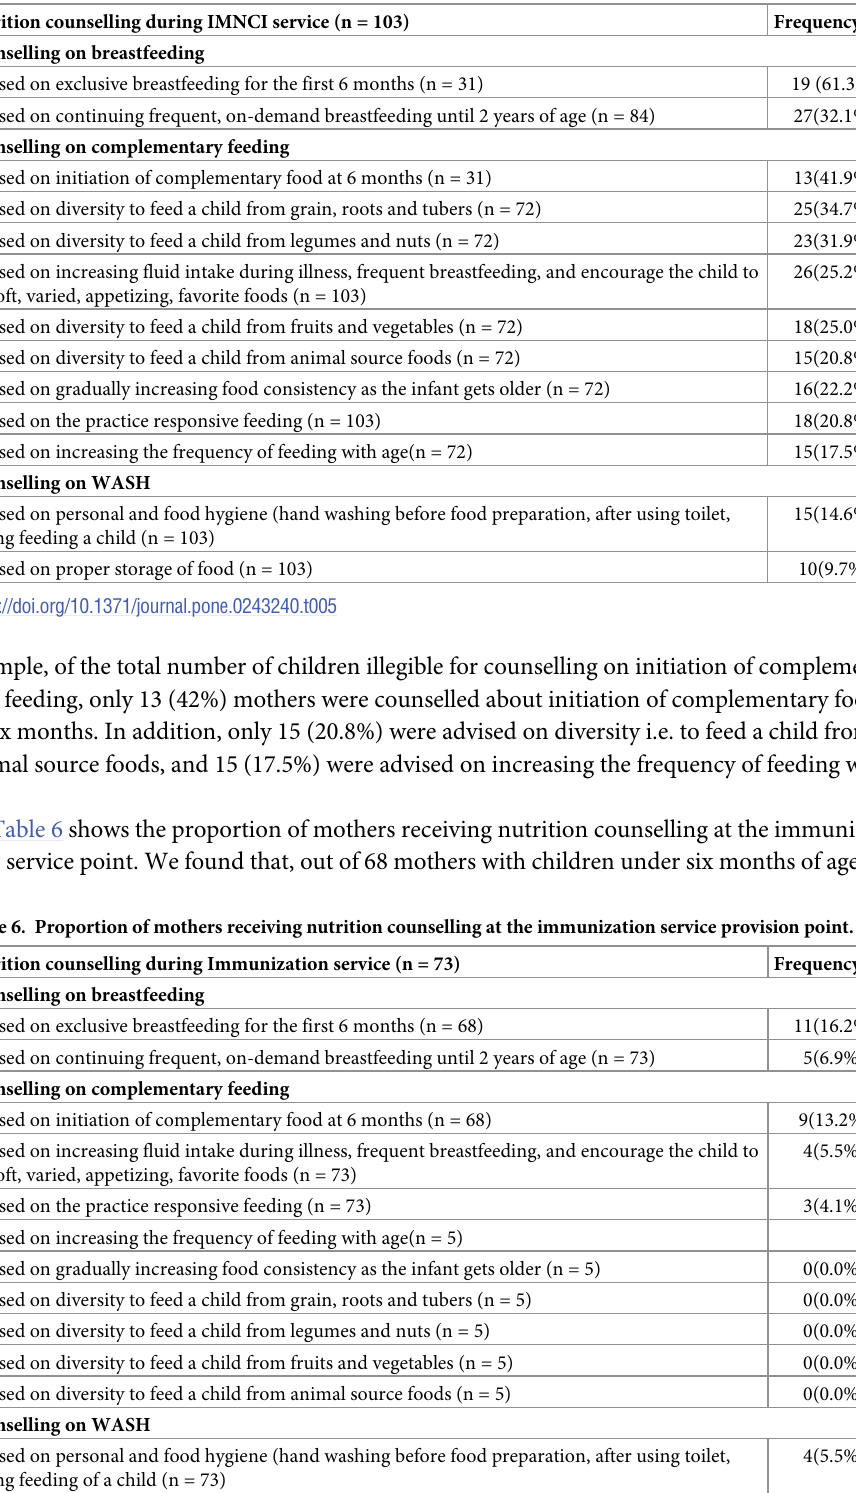
Table 5. Proportion of mother receiving nutrition counselling at IMNCI service provision point.